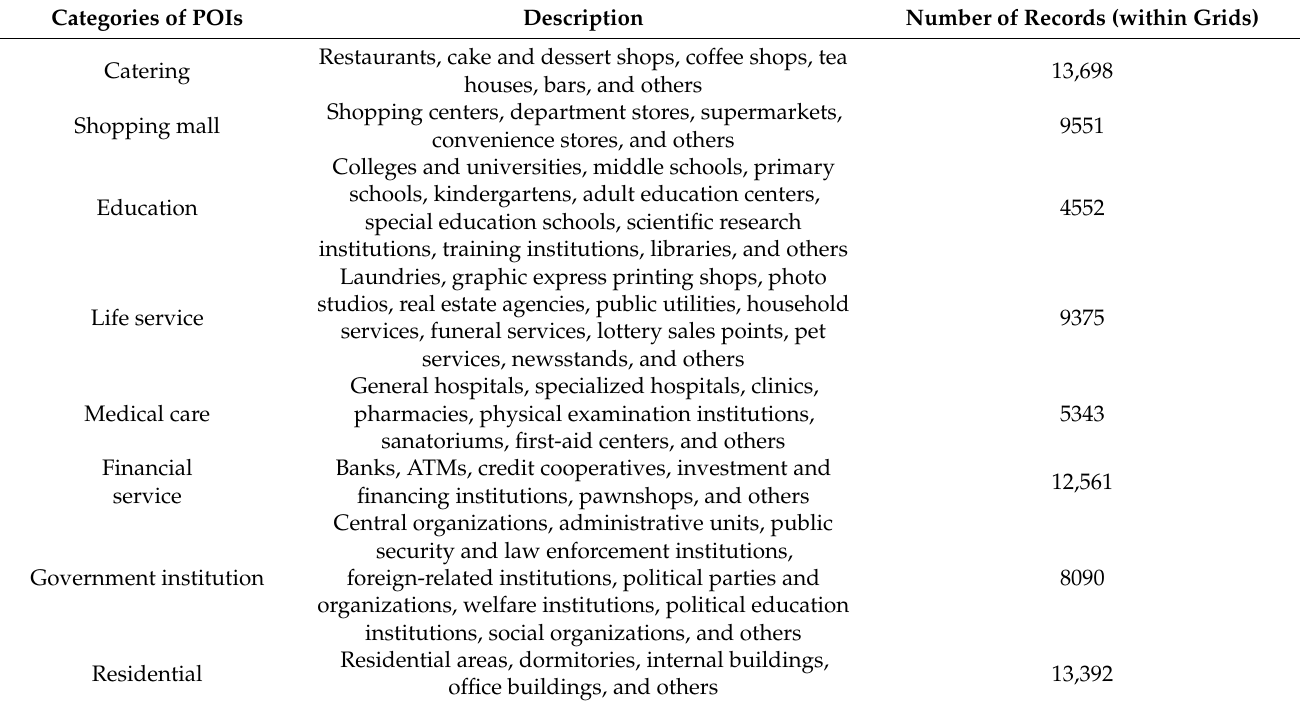
Table 1. Nine POI categories within grids containing retail